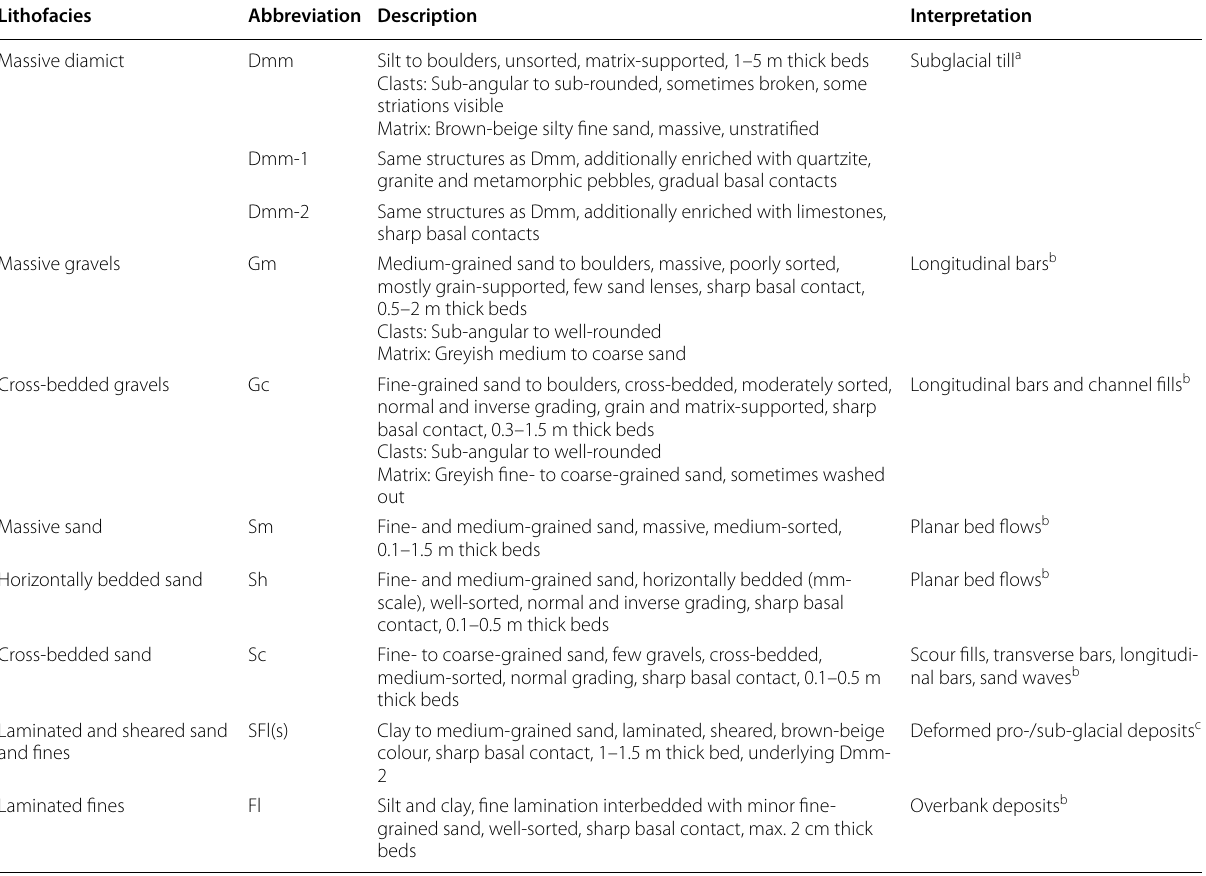
Table 1 Lithofacies elements, related abbreviations, and descriptions of their properties